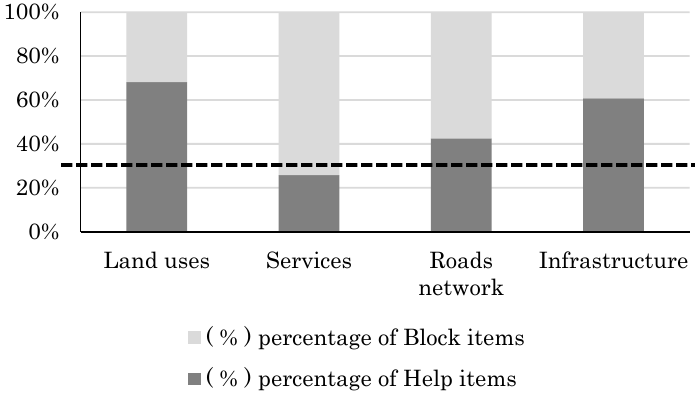
Figure 13. Total percentage for sustainability evaluation items.